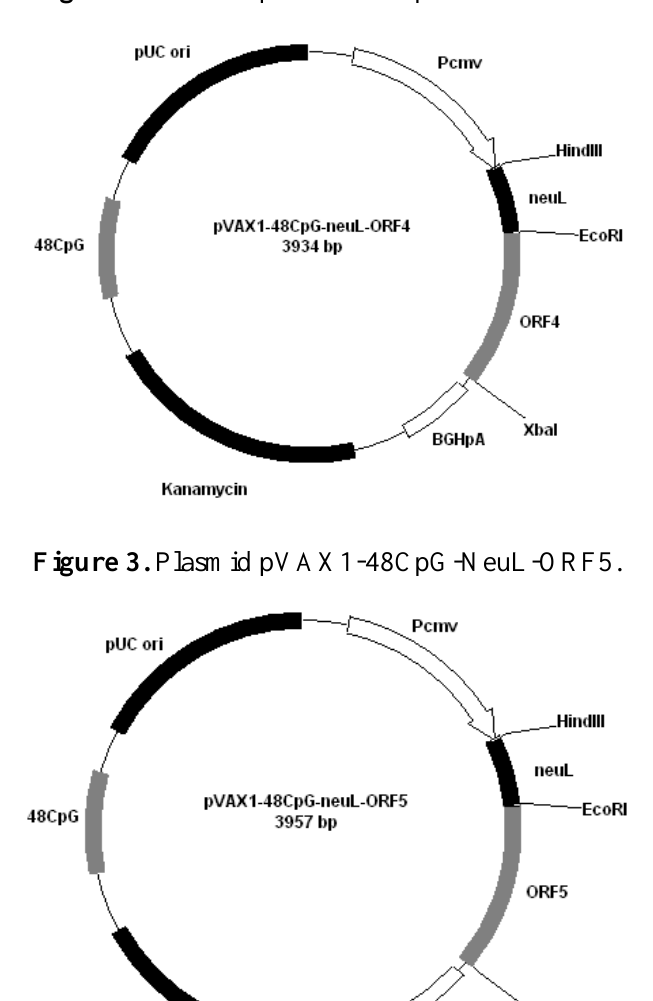
Figure 2. Plasmid pVAX1-48CpG-NeuL-ORF4.